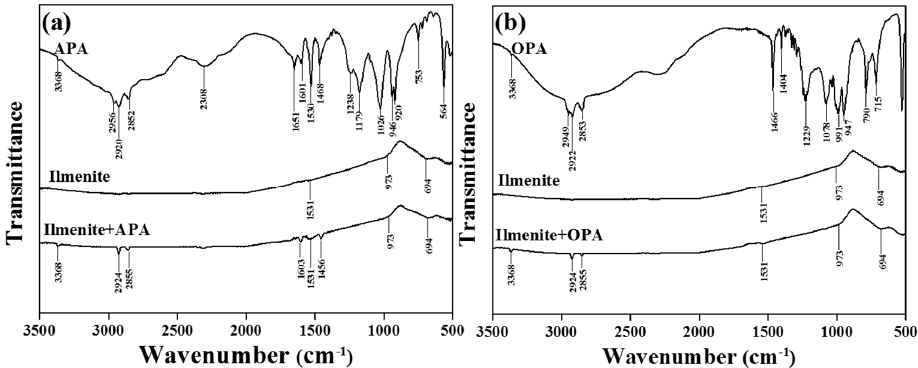
Figure 7. ( a ) FTIR spectra of ilmenite before and after treating with APA. ( b ) FTIR spectra of titanaugite before and after treating with APA.